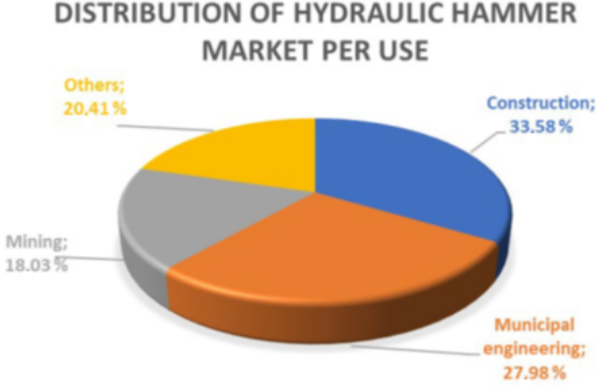
Figure 1. Market share of hydraulic hammering applications